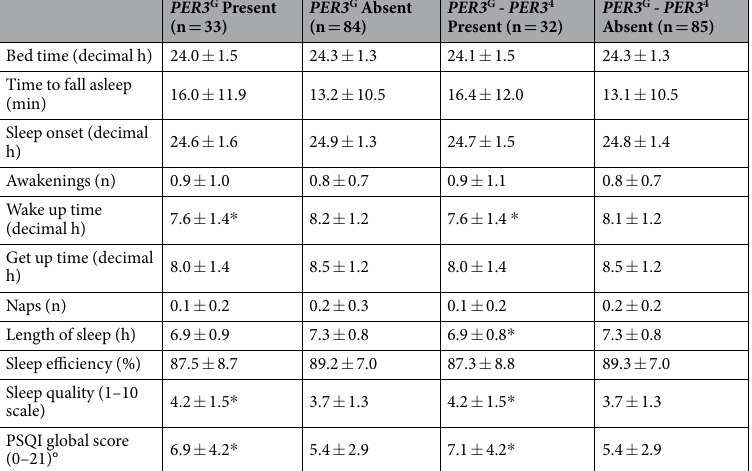
Table 3. Sleep-wake timing and sleep quality indices in relation to the presence/absence of the PER3 G allele and the PER3 G - PER3 4 association. * p < 0.05 on direct comparisons, not confirmed after correction for multiple comparisons (FDR adjusted p > 0.05). °Data available for 37/90 participants with/without the PER3 G allele and for 36/91 participants with/without the PER3 G - PER3 4 association. PSQI: Pittsburgh Sleep Quality